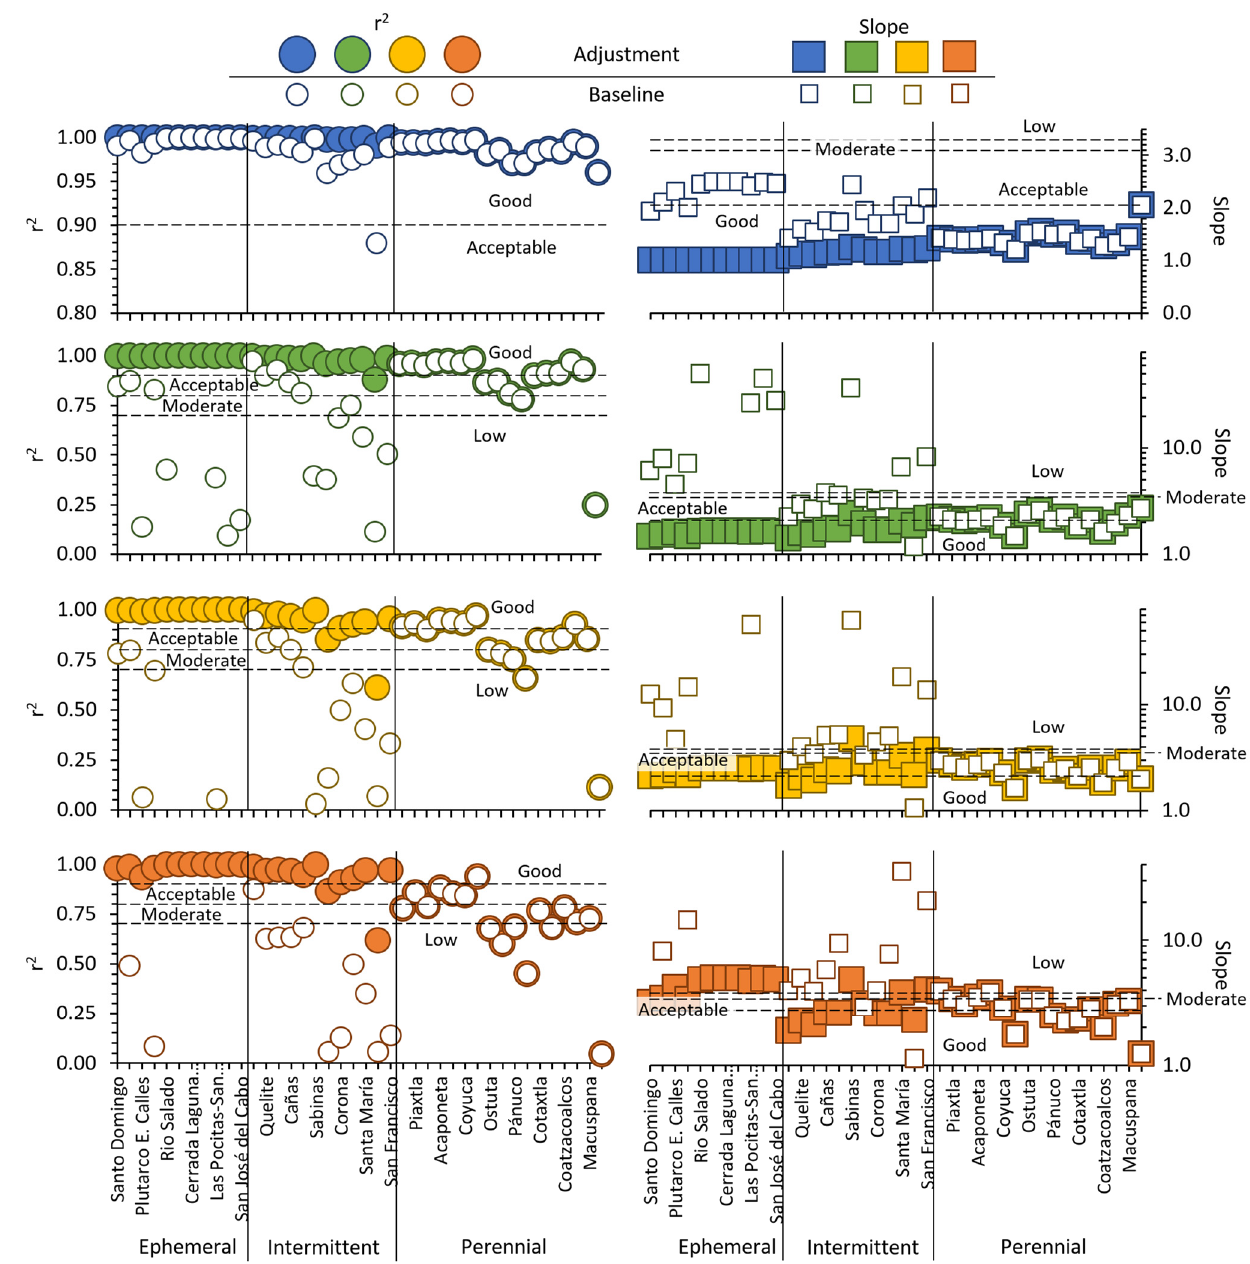
Figure 6. Performance assessment of the baseline and the new (adjustment) reference values of the frequency factors of occurrence per environmental objective class (A = blue, B = green, C = yellow, and D = orange) for environmental water allocation in ephemeral streams, intermittent, and perennial rivers. Coefficients of determination (r 2 ) on the left panel (circles, white baseline, and colored adjustment), and slope values on the right panel (squares, white baseline, and colored adjustment; environmental objective classes B, C, and D displayed at a logarithmic scale). Thresholds for the performance classes displayed dashed lines.